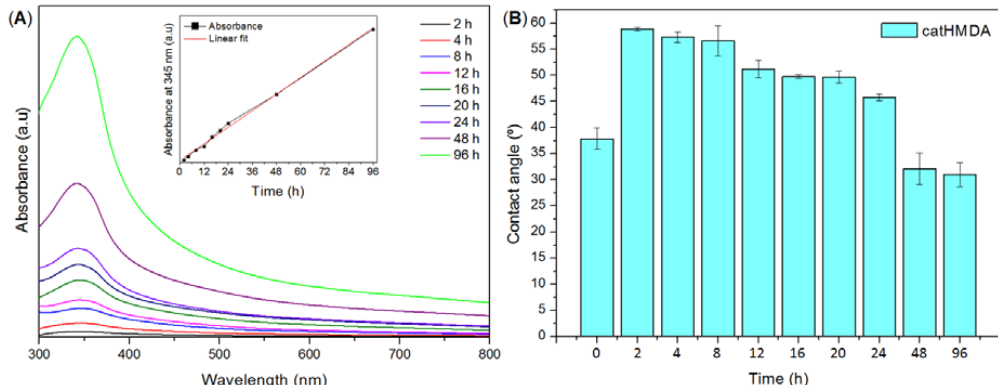
Figure 2. Study of the catHMDA growth with time. ( A ) Ultraviolet–visible (UV–Vis) spectra of catHMDA on glass vs. reaction time. Inset shows the linear trend of the maximum of absorbance at 345 nm as a function of the reaction time. ( B ) Static contact angle measurements of catHMDA-coated glass as a function of the reaction time. Data is shown as mean ± standard deviation. a.u.: Arbitrary units.